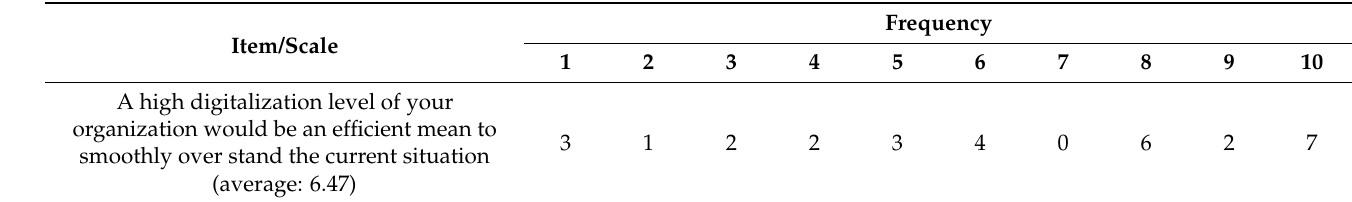
Table 7. Responses obtained for rating if a high digitalization level would help overcoming the current pandemic situation more